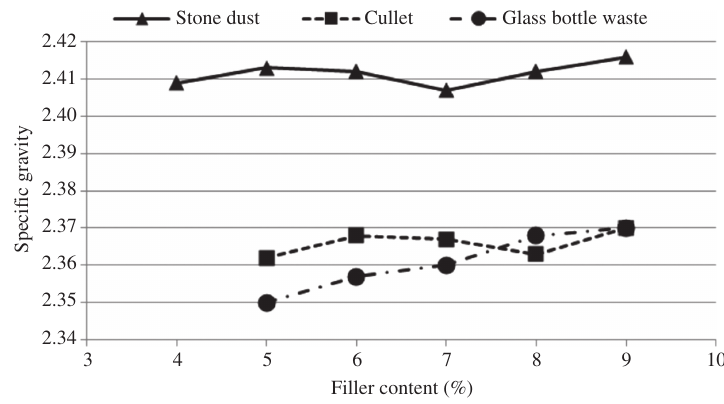
Figure 6 Relationship between specific gravity and filler ratio.